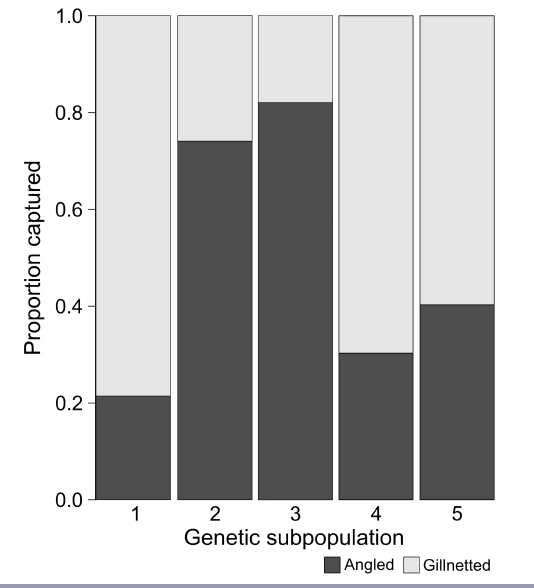
Fig. 5 . Proportion of individual lake trout for each genetically differentiated subpopulation (1–5) that were captured by different methods (angled versus gillnetted) in Mistassini Lake. Details about the genetic demarcation of subpopulations are described in Marin et al.